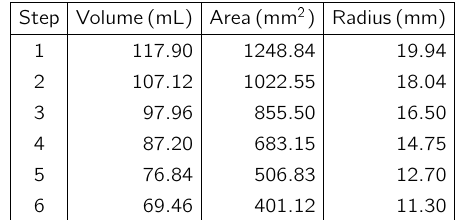
Table 1: Measured volumes inside the silicone ventricle from CT measurements. Cross-sectional areas obtained between the center electrode pair. Estimated equivalent center